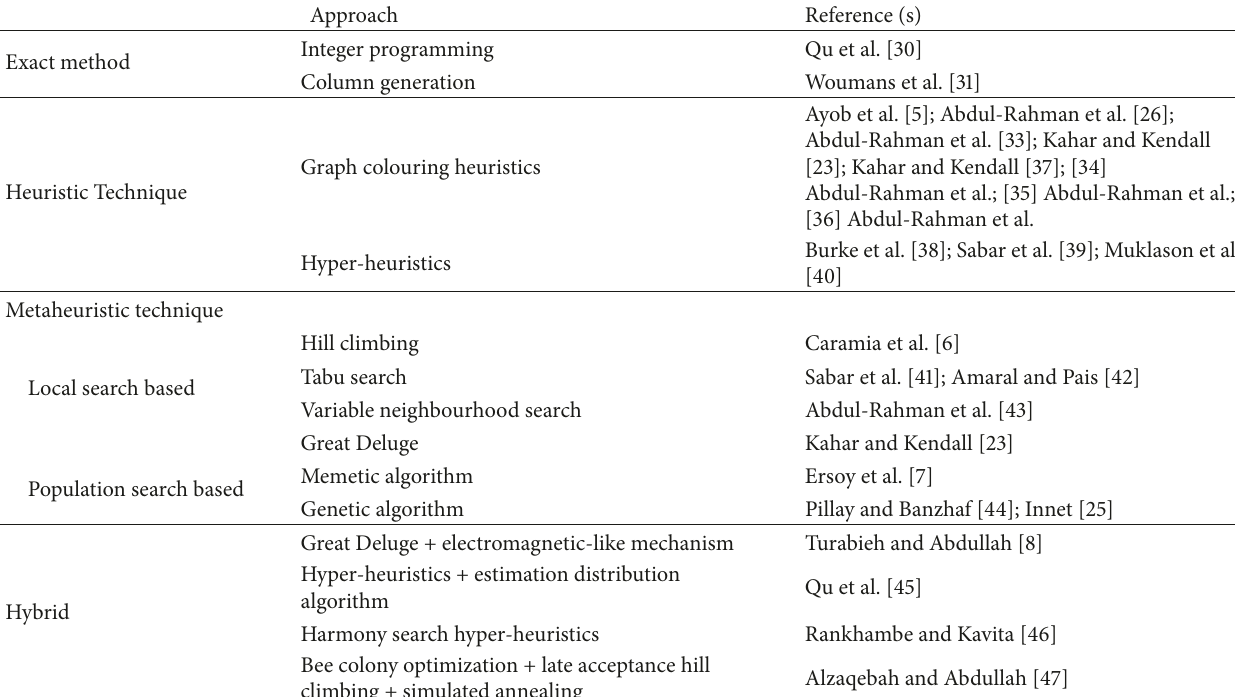
Table 3: Summary of related studies in